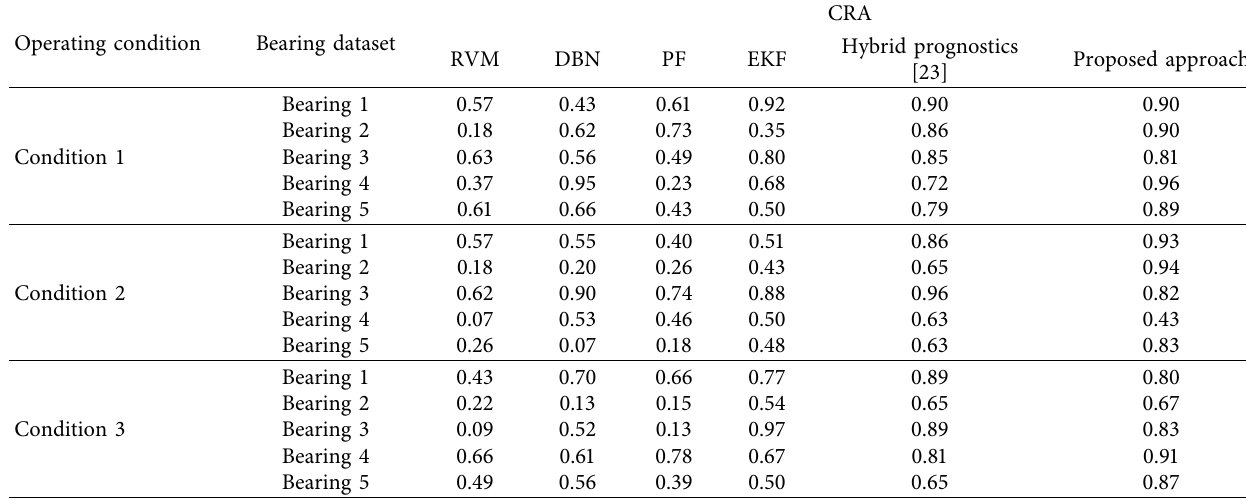
Table 5: Performance evaluation for the six prognostics approaches using CRA.